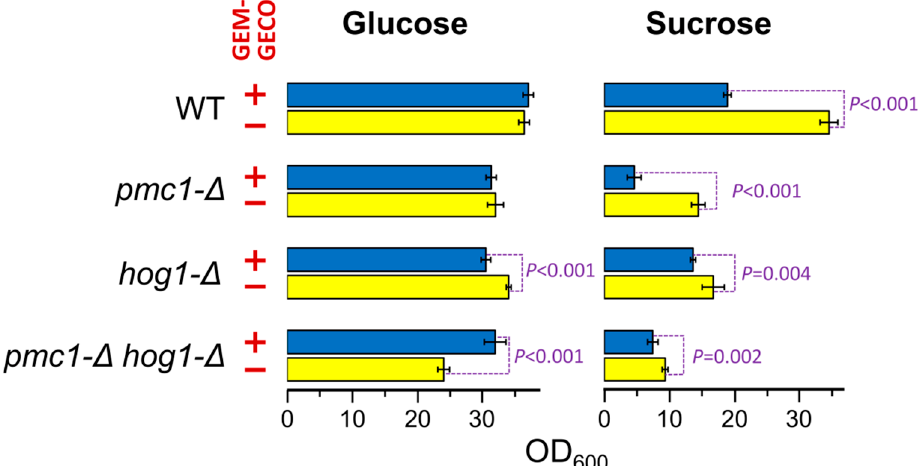
Figure 1. Effect of GEM-GECO expression on OD 600 of saturated cultures of strains bearing wild-type or deletion alleles of the PMC1 and HOG1 genes. Overnight YPD cultures were 100-fold diluted with YPD (Glucose) or YP-Suc (Sucrose) medium and incubated at 37 °C for 24 h. WT, DL5-LC (+) and DL1-LC ( − ) strains; pmc1- Δ , DL5-pmc1-LC (+) and DL-pmc1-LC ( − ) strains; hog1- Δ , DL5-hog1 (+) and DLdaduA-hog1-UC ( − ) strains; pmc1- Δ hog1- Δ , DL5-pmc1-hog1 (+) and DLdaduA-pmc1-hog1 ( − ) strains. The means with standard deviations and P -values were calculated from data obtained in six replicates.